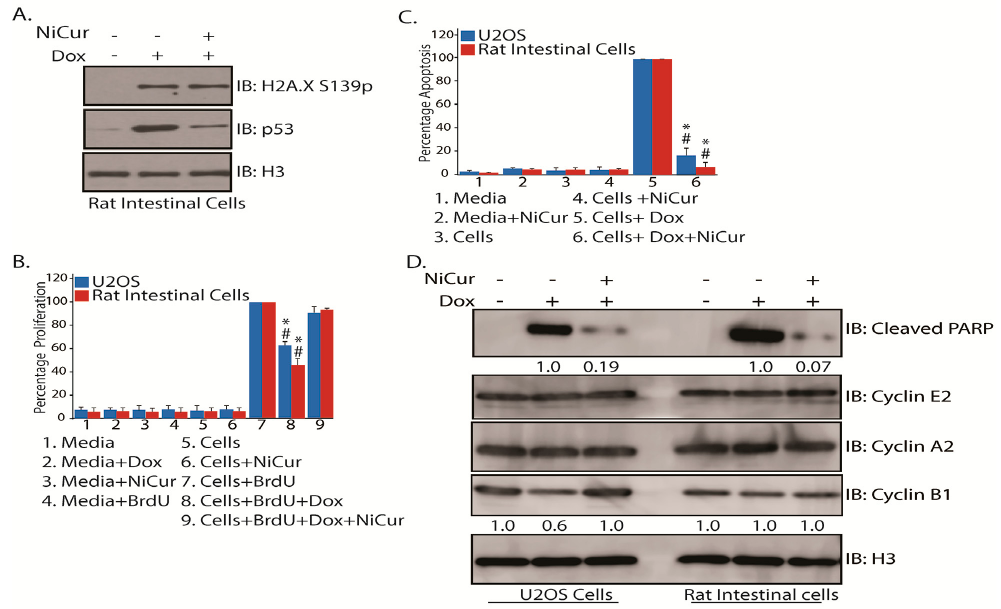
Figure 5. NiCur inhibits cellular proliferation and apoptosis in U2OS and normal rat gastrointestinal epithelial cells. ( A ) NiCur downregulates Dox-mediated p53 activation in normal rat intestinal cells without affecting the levels of H2A.X S139p; ( B ) Incorporation of BrdU after treatment of U2OS and normal rat gastrointestinal epithelial cells with Dox in presence and in absence of 1.5 µ M of NiCur was quantitated by measuring optical density (OD) at 450 nm. The OD obtained was normalized to 100% for BrdU-treated U2OS and normal rat intestinal epithelial cells, and then, all the conditions (1–9) were calculated as 100 *OD/OD of BrdU-treated cells; ( C ) The intracellular levels of Cleaved Caspase 3 in U2OS and normal rat gastrointestinal epithelial cells after treatment with Dox in presence and in absence of 1.5 µ M of NiCur was measured at OD of 450 nm. The OD was normalized to 100% for Dox-treated U2OS and normal rat intestinal epithelial cells and then, all the conditions (1–6) were calculated as 100 *OD/OD of Dox-treated cells. All experiments were performed in triplicates of technical and biological repeats. The experimental values are expressed as the mean ± SEM ( n = 3 ), with significance at p < 0.05 or p < 0.01 indicated by * and #, respectively. ( D ) NiCur downregulates p53-mediated apoptosis in U2OS and normal rat intestinal epithelial cells as demonstrated by the attenuation of cleavage of PARP without affecting the levels of Cyclins A2 and E2. The signals for the levels of Cleaved PARP after Dox treatment in U2OS and gastrointestinal epithelial cells were determined by densitometry and then normalized to 1 and later the effect of NiCur was calculated respectively. Besides, p53-mediated downregulation of the expression of Cyclin B1 in U2OS cells was restored by 1.5 µ M of NiCur treatment.